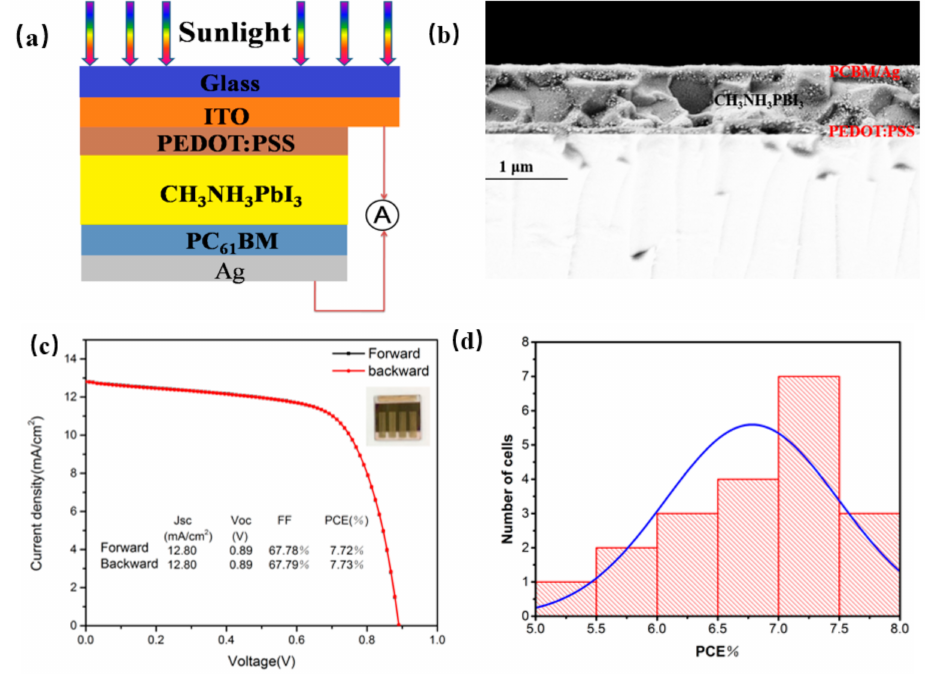
Figure 10. ( a ) Architecture of the devices, ( b ) cross-section of solar cell, ( c ) current density–voltage ( J – V ) curve of the champion single-source thermal evaporation MAPbI 3 device, and ( d ) histograms of power conversion efficiency (PCE) of 20